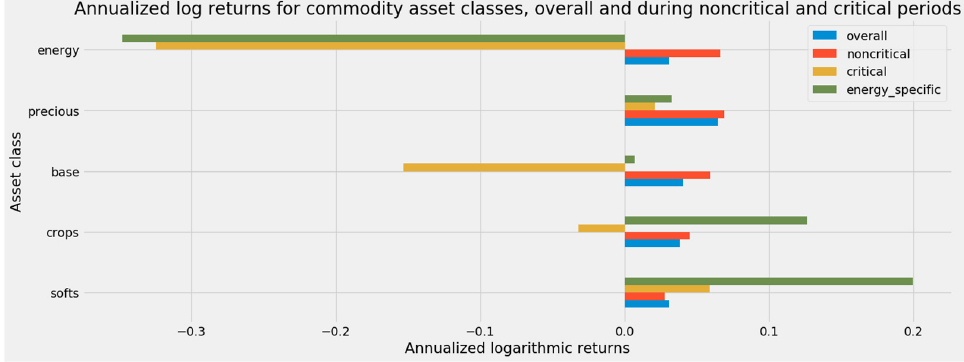
Figure 42. Annualized logarithmic returns for commodity asset classes, overall and during noncritical and critical periods.